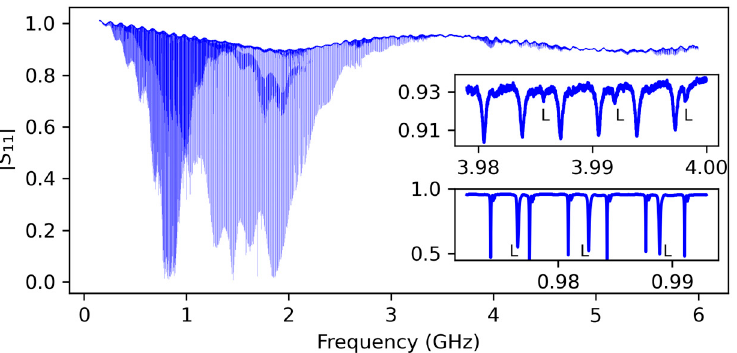
Figure 2. Frequency dependence (spectrum) of the microwave reflection coefficient | S 11 ( f )| in the absence of a magnetic field. The insets show two enlarged fragments of the spectrum. The dips in the frequency characteristics correspond to the resonant frequencies of the shear AW (not marked) and longitudinal AW (L) thickness modes; the intermodal distance of the longitudinal modes is approximately two times greater than that of the shear ones.